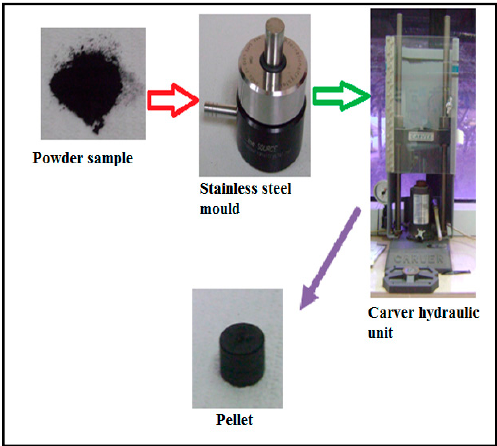
Figure 5. Steps of preparing graphite ‐ PVC pellet.